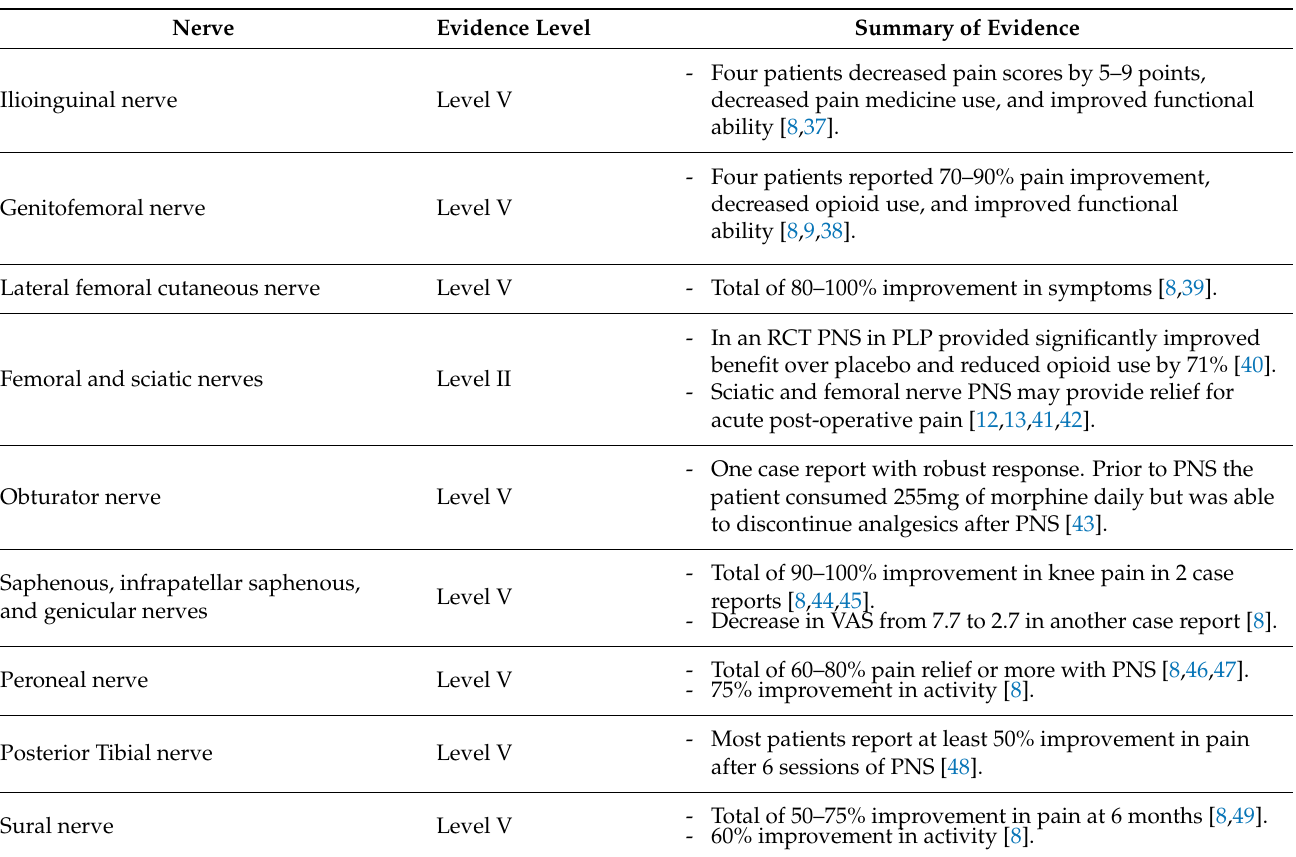
Table 2. Individual nerves of the lower extremity described by level of evidence as well as a summary of